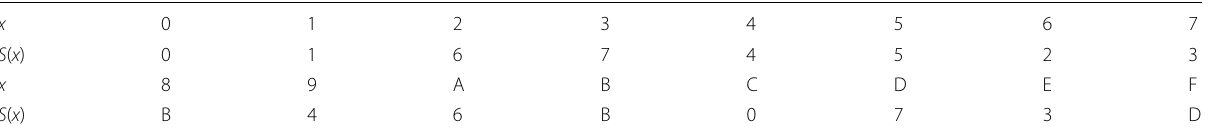
Table 3 The S-box S appeared in encryption process of FeW